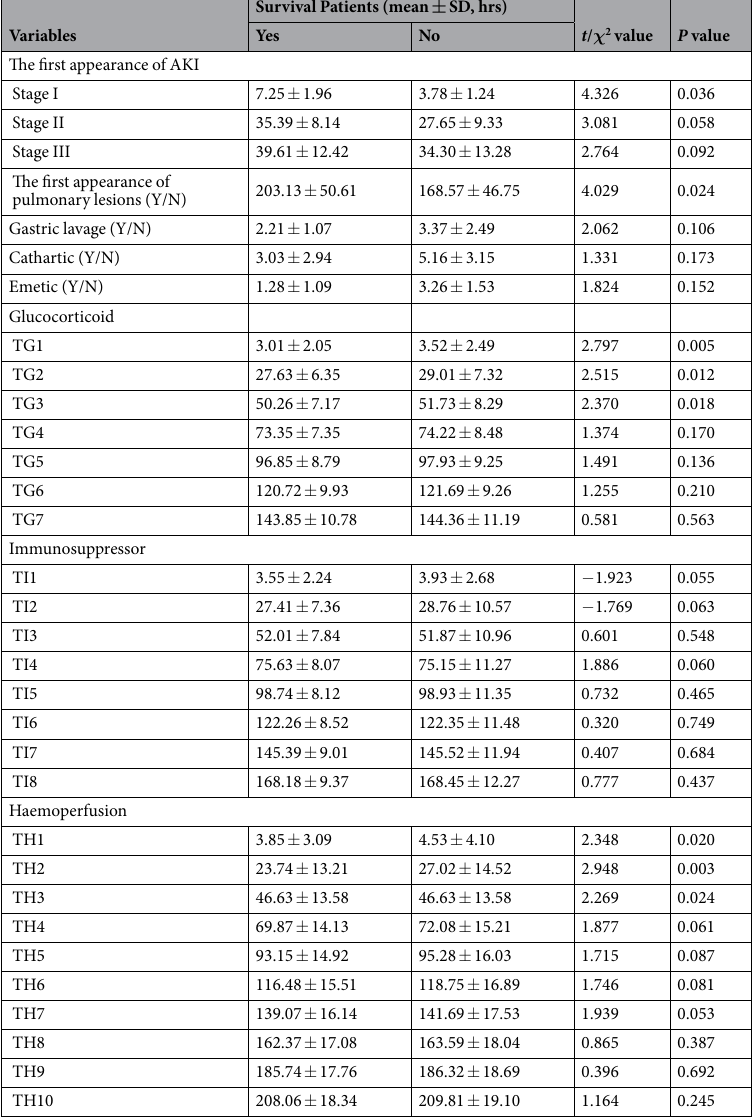
Table 2. Time difference between survival and death patients within tests and therapies after PQ poisoning. AKI: Acute kidney injury. TG1, TG2 … TG7: the first, second … seven time use of glucocorticoid. TI1, TI2 … TI8: the first, second … eight time use of immunosuppressor. TH1, TH2 … TH10: the first, second … ten time use of